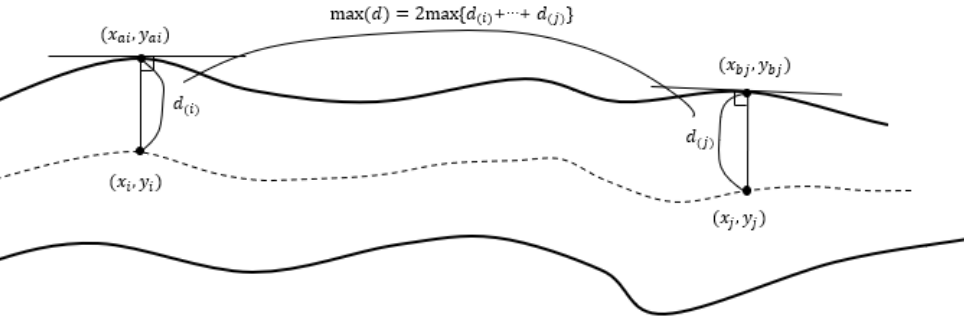
Figure 10. Maximum crack width calculation diagram.